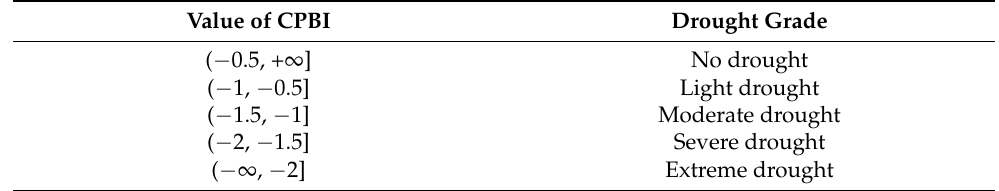
Table 6. CPBI drought classification. Value of CPBI Drought